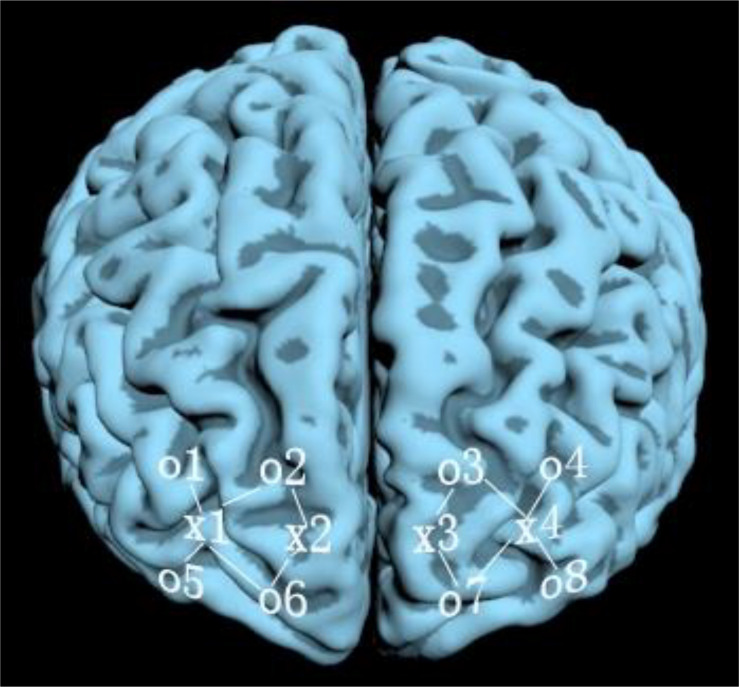
Area of prefrontal cortex map measured using fNIRS in Experiment 3. The symbol “o” before a numeral stands for a detector optode; “x” before a numeral stands for a laser optode.